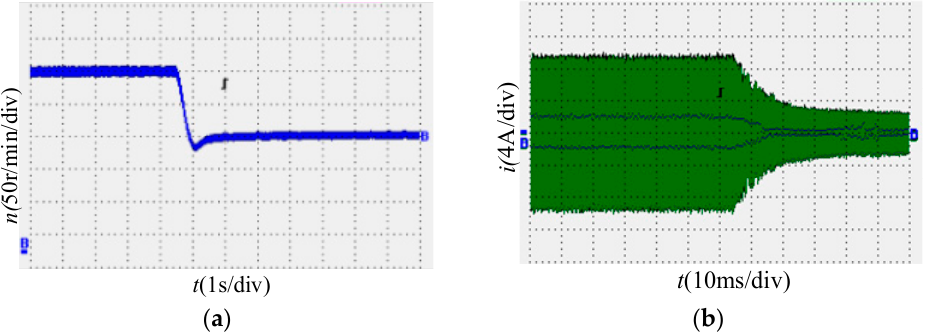
Figure 26. Waveform of the motor under sudden load: ( a ) speed waveform; ( b ) current waveform of the six-phase motor.